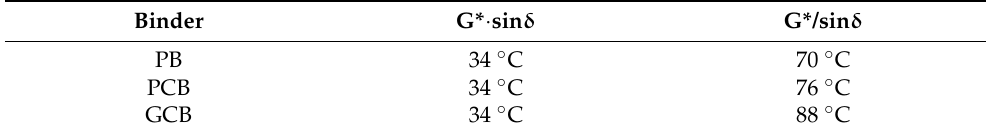
Table 6. Temperature limits at which SHRP requirements are met.